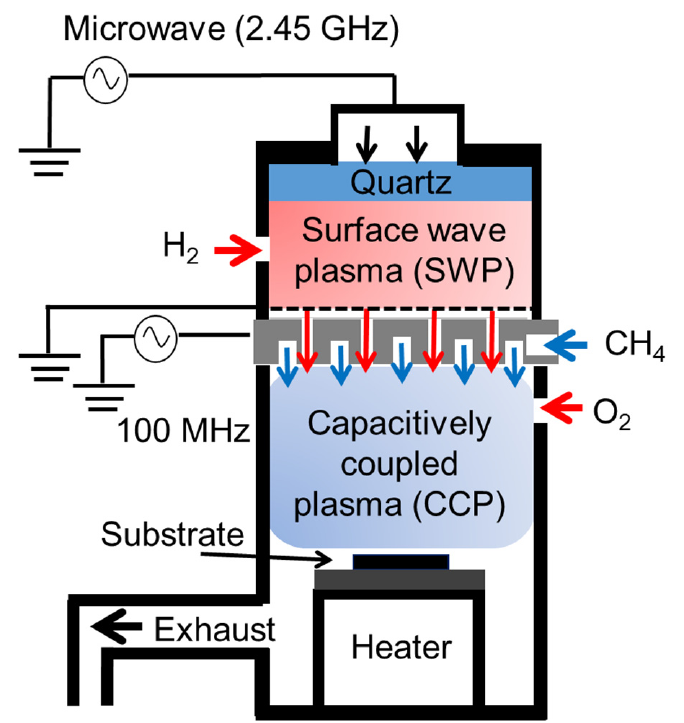
Figure 1. Radical-injection plasma-enhanced chemical vapor deposition (RI-PECVD) system with CH 4 , H 2 , and O 2 gases.